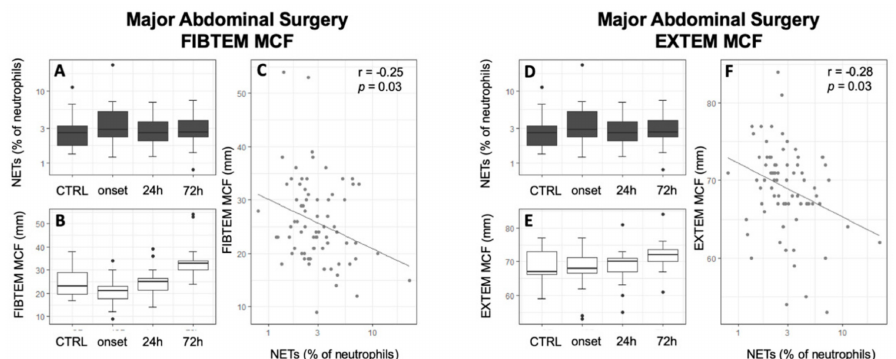
Figure 6. Inverse correlation of free-circulating NETs to FIBTEM MCF in major abdominal surgical patients. Time courses of NETs ( A , D ), FIBTEM MCF ( B ), and EXTEM MCF ( E ) are shown as boxplot diagrams while scatter plots are uses to present correlation between NETs and FIBTEM MCF ( C ) and EXTEM MCF ( F ). Abbreviations: CTRL: Control group; MCF: Mean Clot Firmness; NETs: Neutrophil Extracellular Traps; r: Pearson’s Correlation Coe ffi